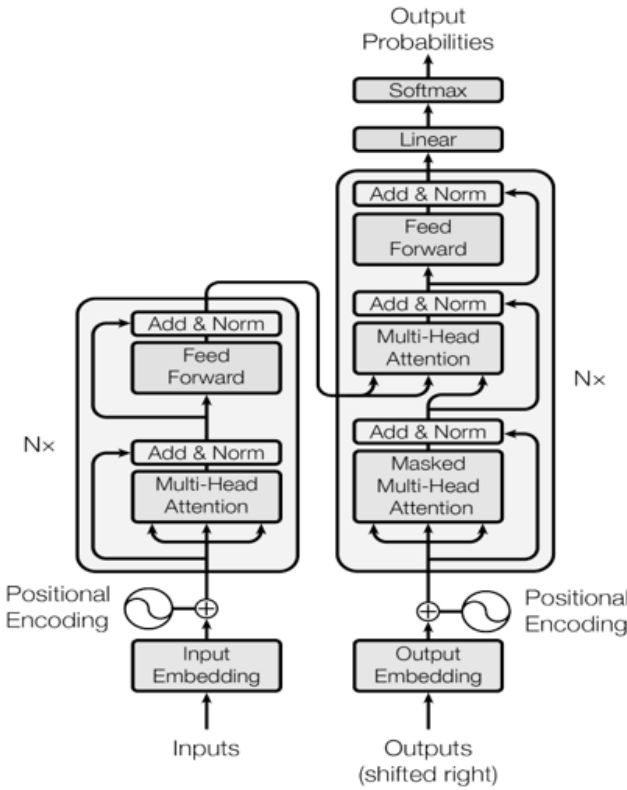
Figure 11. Model architecture of transformer.